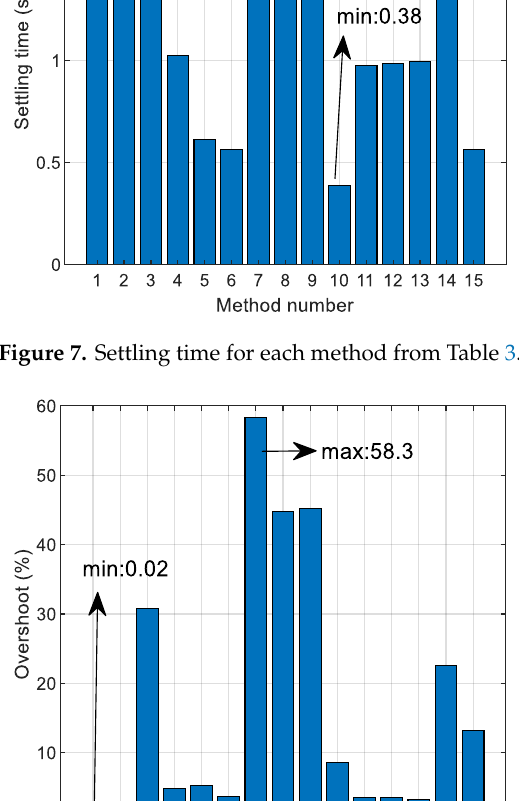
Figure 8. Overshoot for each method from Table 3.